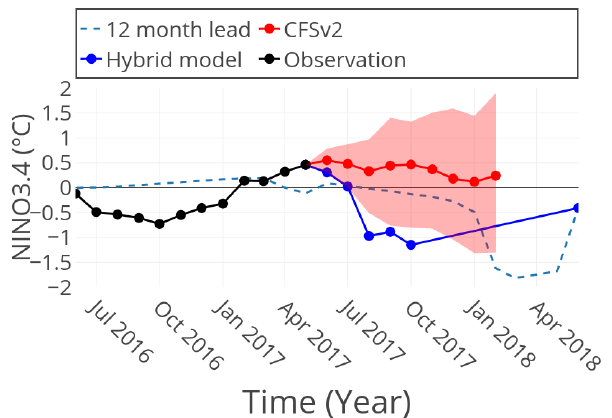
Figure 10. NINO3.4 prediction from May 2017. In black the ob- served index until May 2017. Red is the CFSv2 ensemble predic- tion mean and the shaded area is the spread of the ensemble. The hybrid model prediction in blue is given by predictions from hybrid models found to be most optimal at the different lead times with ARIMA(12,1,0). The dashed blue line is the running 12-month lead time